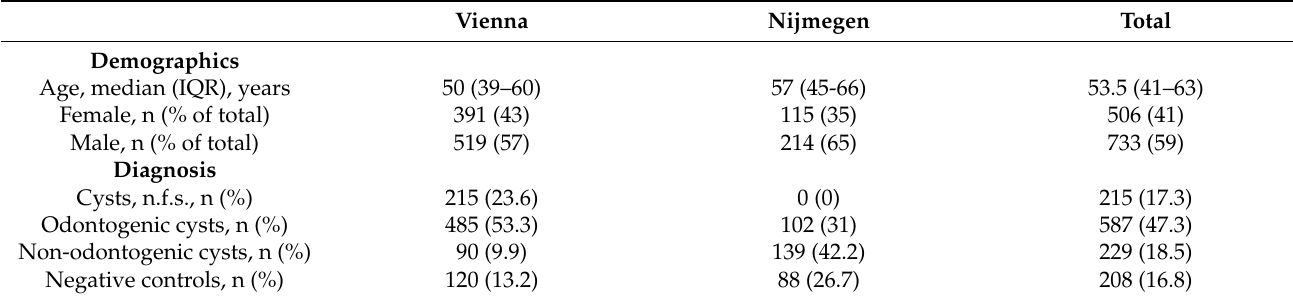
Table 1. Dataset